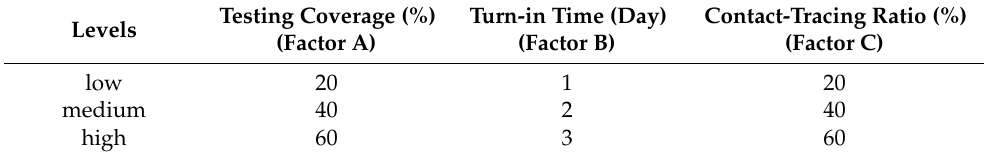
Table 2. Factor settings of simulation experiment.